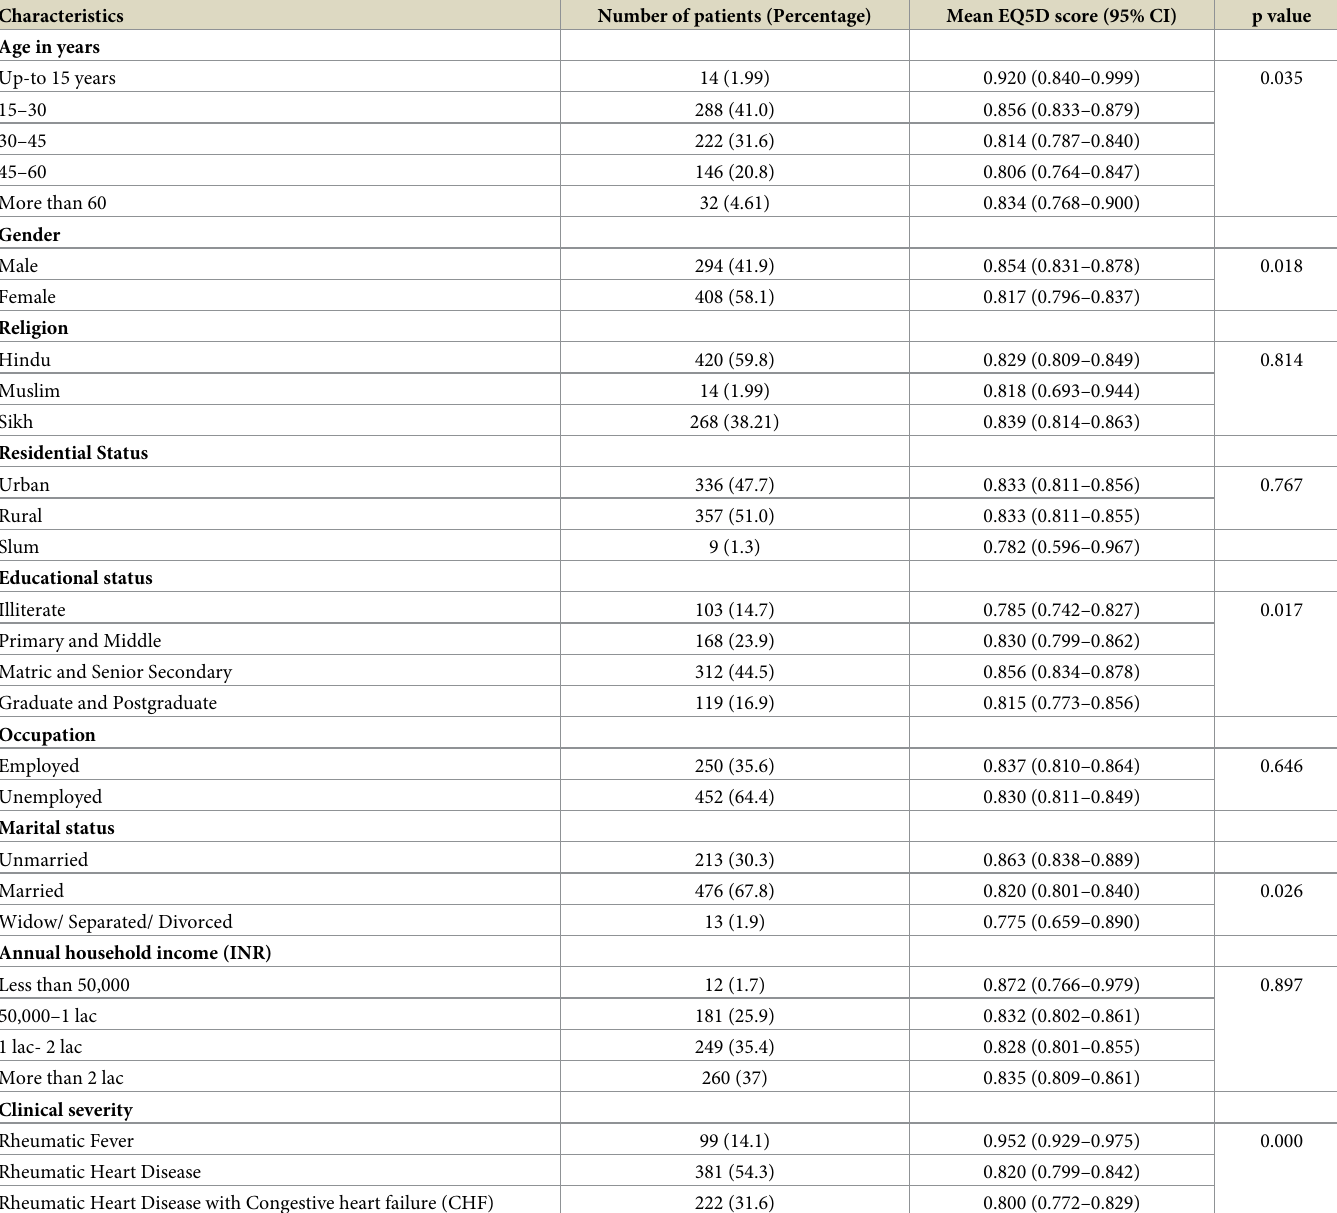
Table 1. EQ-5D-5L scores among different socio-demographic groups of Rheumatic fever and Rheumatic heart disease patients.